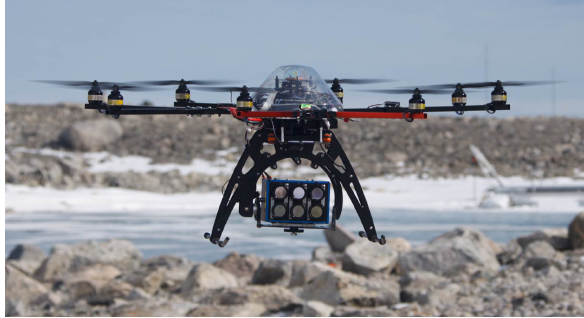
Figure 3: OktoKopter micro-UAV with 6-band multispectral sen- sor mounted on stabilised camera platform.